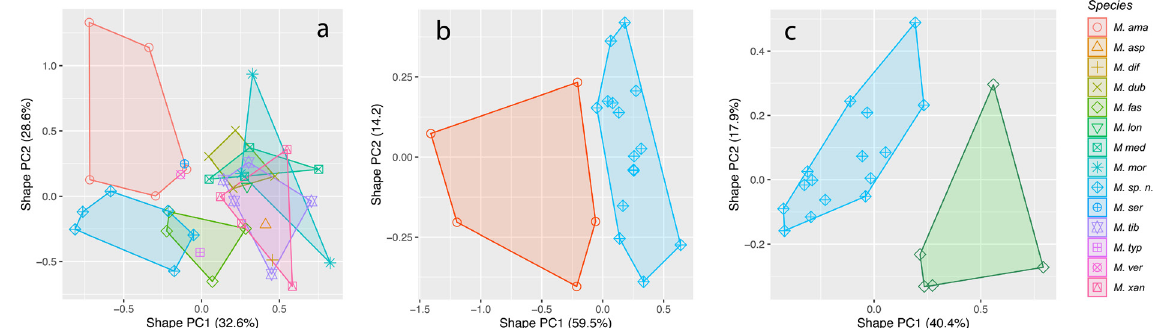
Fig. 1. Scatterplot of first against second shape PC based on 19 morphometric variables of females. a . All 14 species of Mesopolobus Westwood, 1833. b . M. amaenus (Walker, 1834) and Mesopolobus robiniae Lakatos & László sp. nov. emerged from black locust seedpods. c . M. fasciiventris Westwood, 1833 and Mesopolobus robiniae Lakatos & László sp. nov. emerged from black locust seedpods. The variance explained by each shape PC is given in